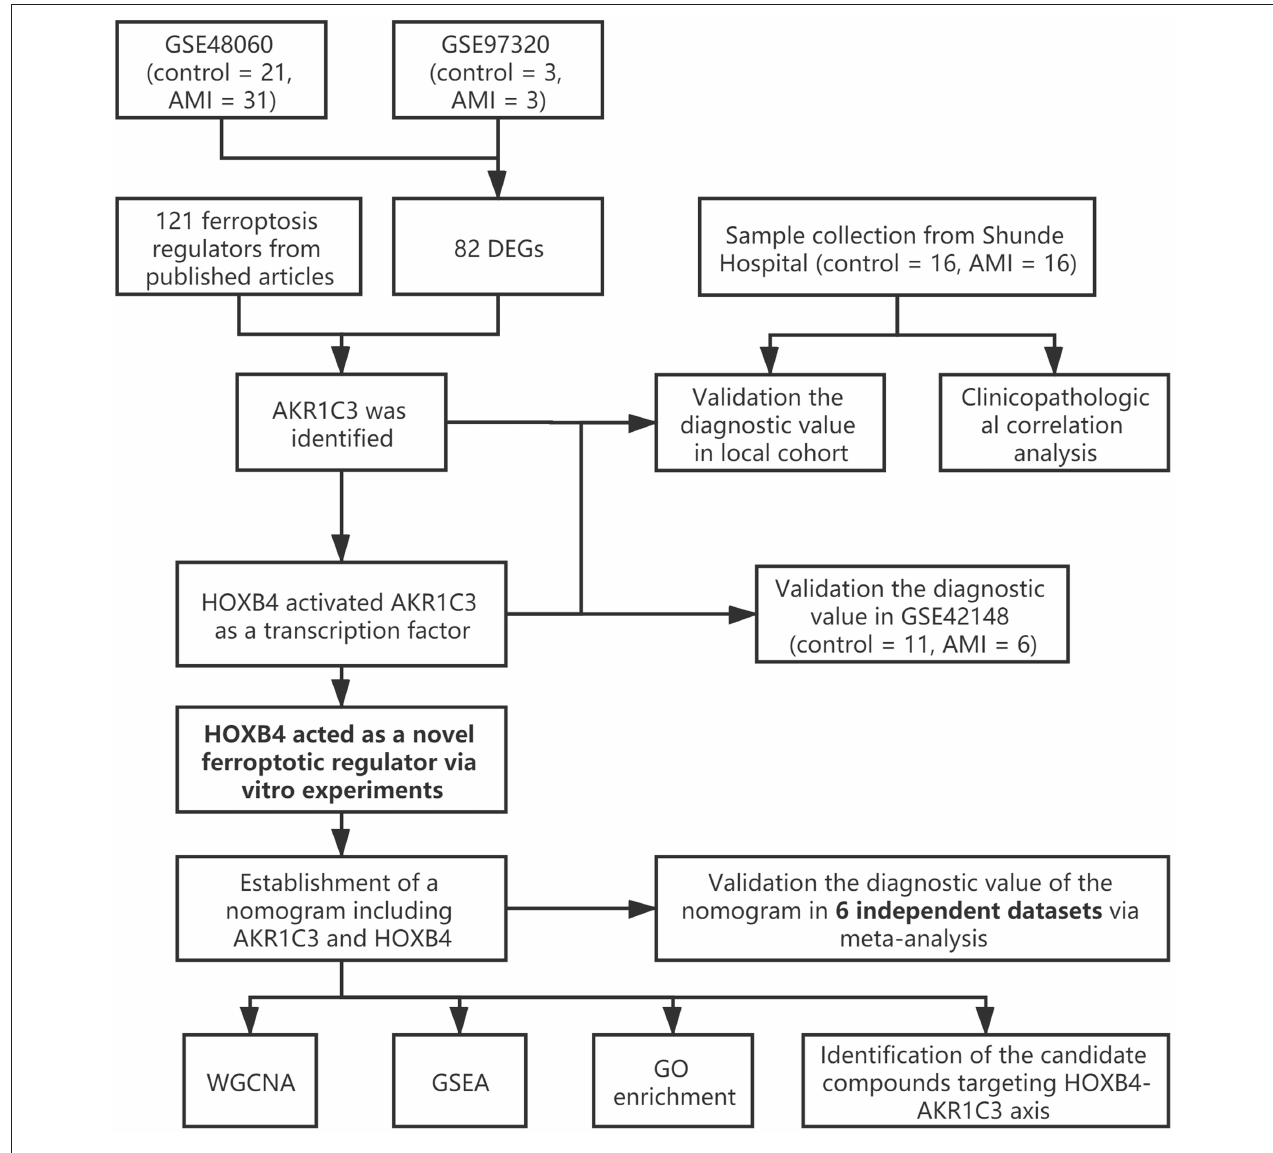
FIGURE 1 | The workflow of the present